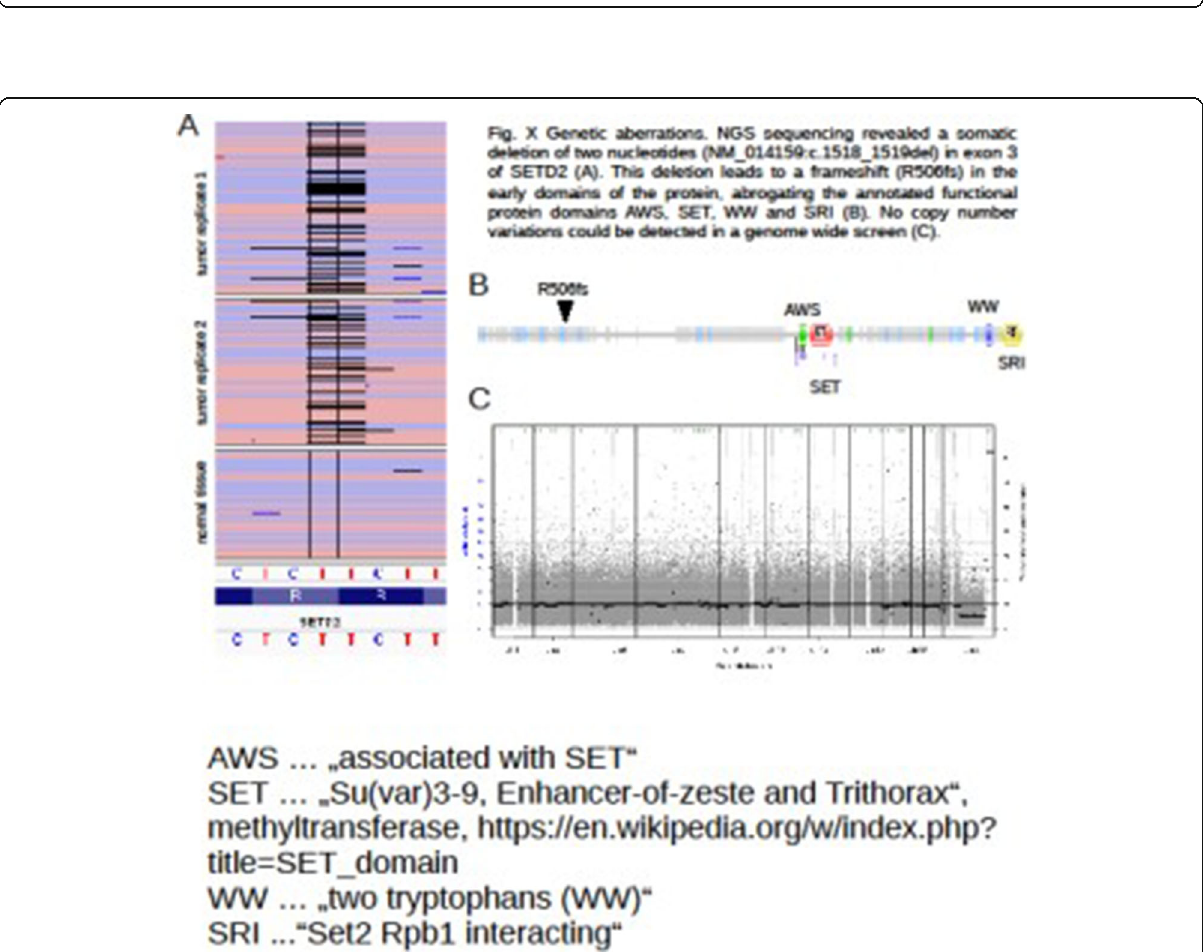
Fig. 7 Tumour tissue infiltrating the mandibular bone, which leads to distinct osseous thinning. The bone is covered by the mucosal membrane